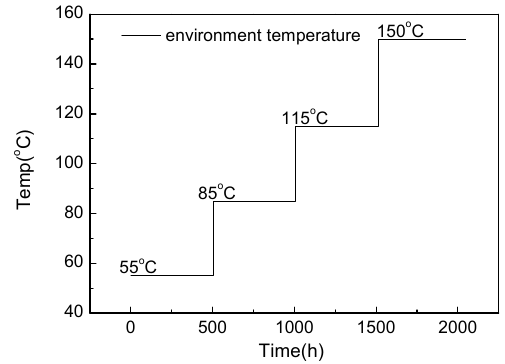
Figure 4. Illustration of the 4-step stress accelerated degradation test.